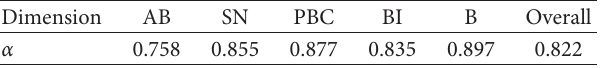
Table 6: Cronbach’s alpha coefficients of the research variables.